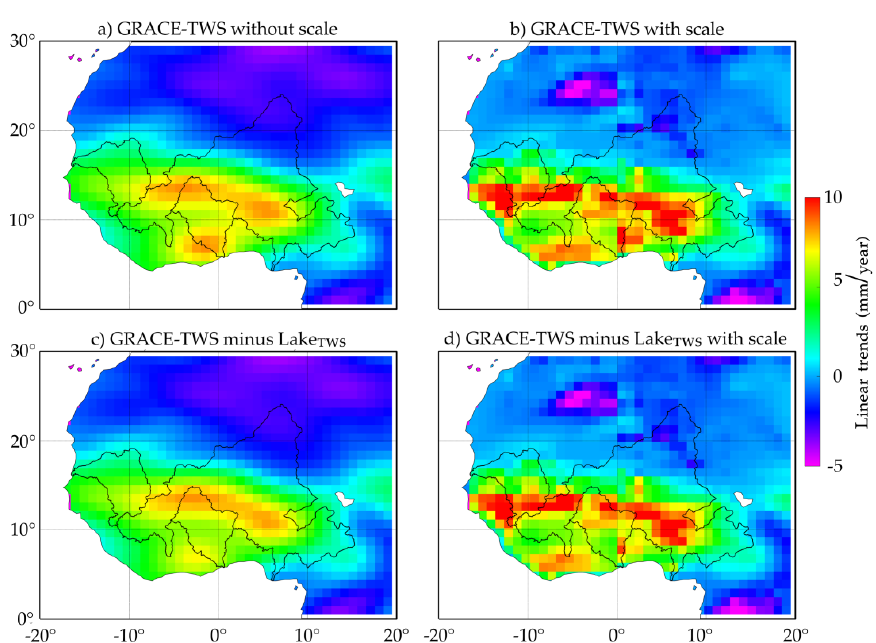
Figure 6. The rate of change in terrestrial water storage (TWS) loss or gain averaged over the entire